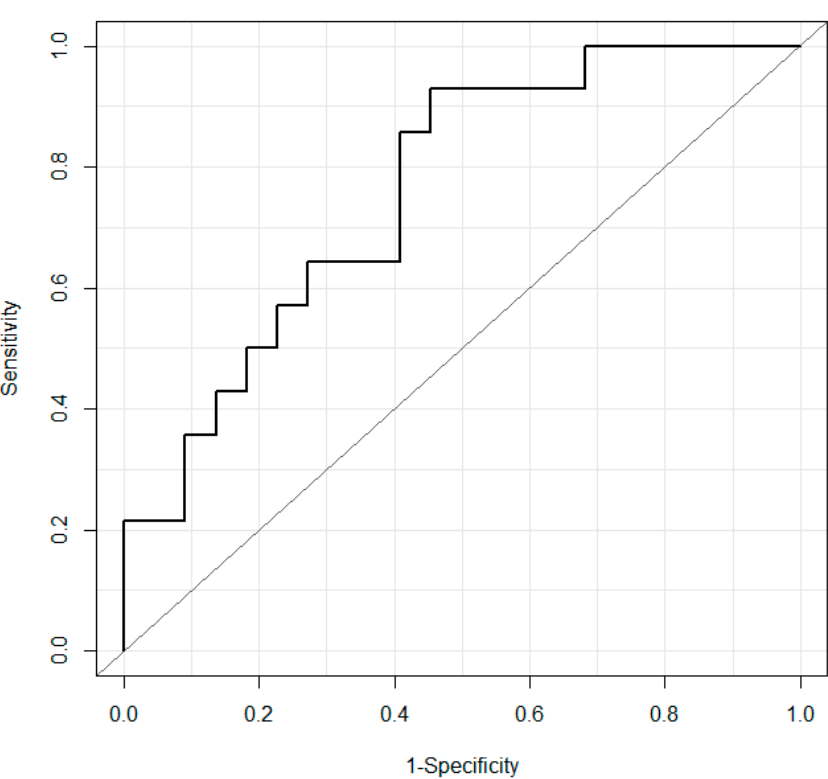
Figure 5. Receiver operating characteristic curves when using vitality to identify groups. The straight line represents y = x.